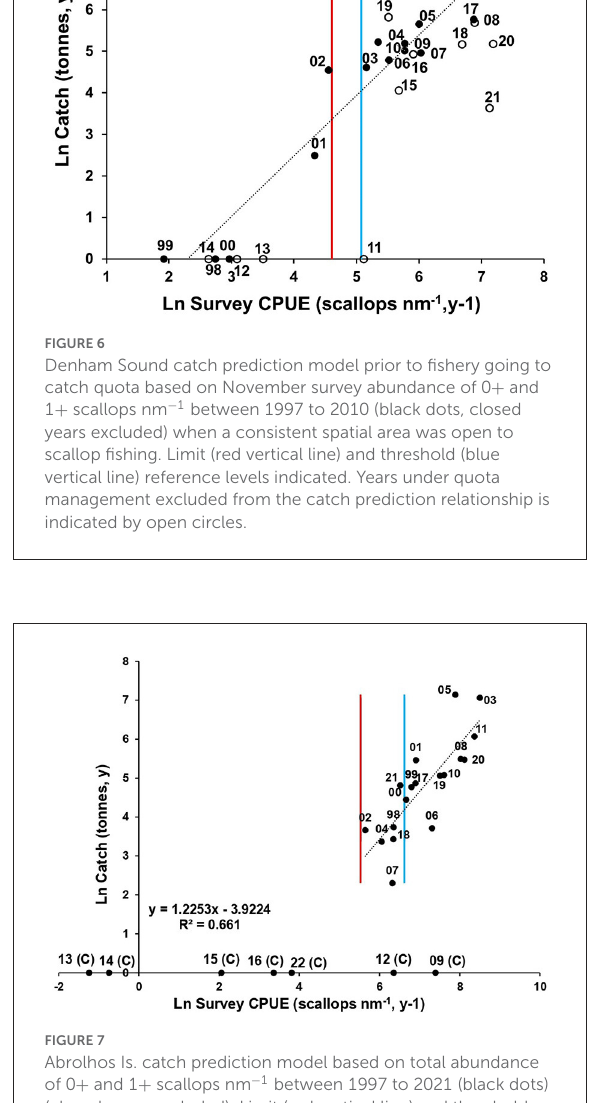
SBN until June 2021 (Figure 8). Generally, 0 + ( ≤ 83 mm